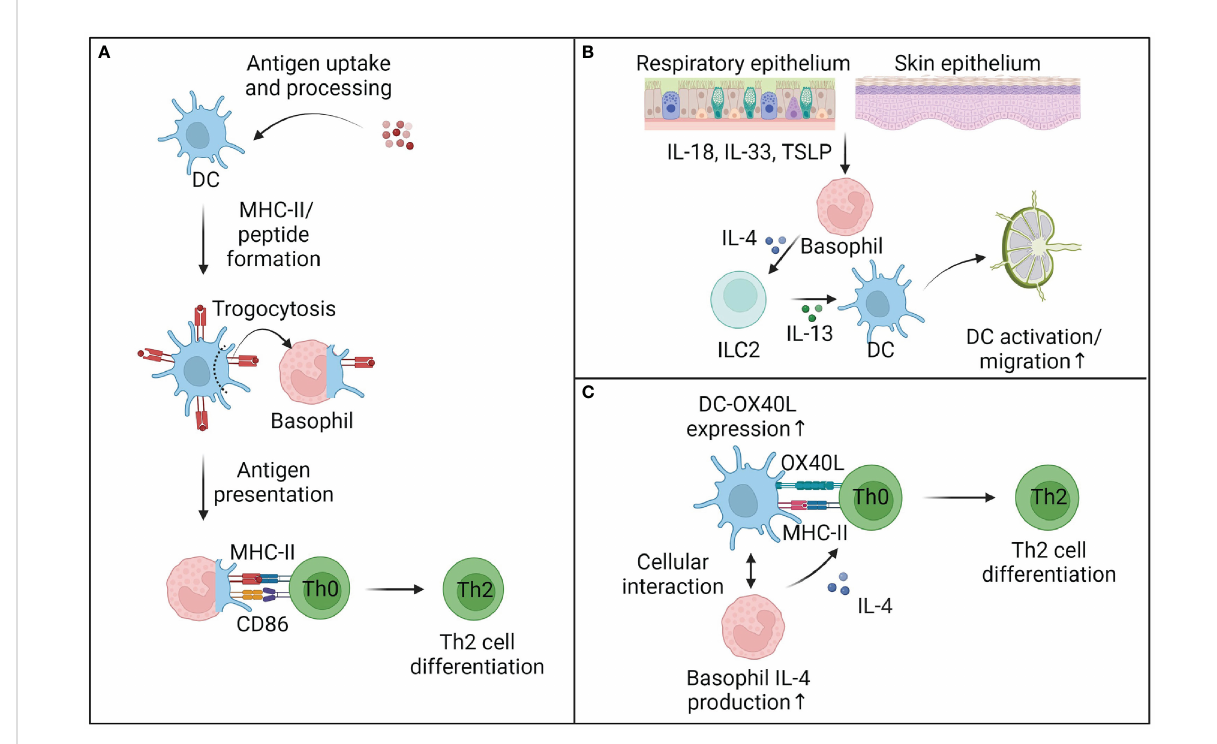
FIGURE 2 Mechanisms of basophil-enhanced antigen presentation. (A) Basophils can cooperate with dendritic cells (DC) to prime T cells. While basophils cannot take up and process complex antigens, they can trogocytose parts of cell membranes and antigen-loaded MHC-II complexes from DC and thus directly in fl uence Th2 cell differentiation. It remains unclear to what extent trogocytosis plays a role in vivo , but other mechanisms of basophil-enhanced antigen presentation are well described. (B) In tissues, basophil-derived IL-4 activates murine innate lymphocytes type 2 (ILC2), which produce IL-13 and other mediators and activate DC to migrate to the draining lymph nodes. (C) Within lymph nodes, basophils can enhance DC activation and OX40L expression, while also providing early IL-4 to support the differentiation of Th2 cells. Although the requirement of early IL-4 for the differentiation of Th2 cells is debated, multiple studies provide evidence that basophils directly support the priming of Th2 cells, at least in the murine system. This fi gure was created using